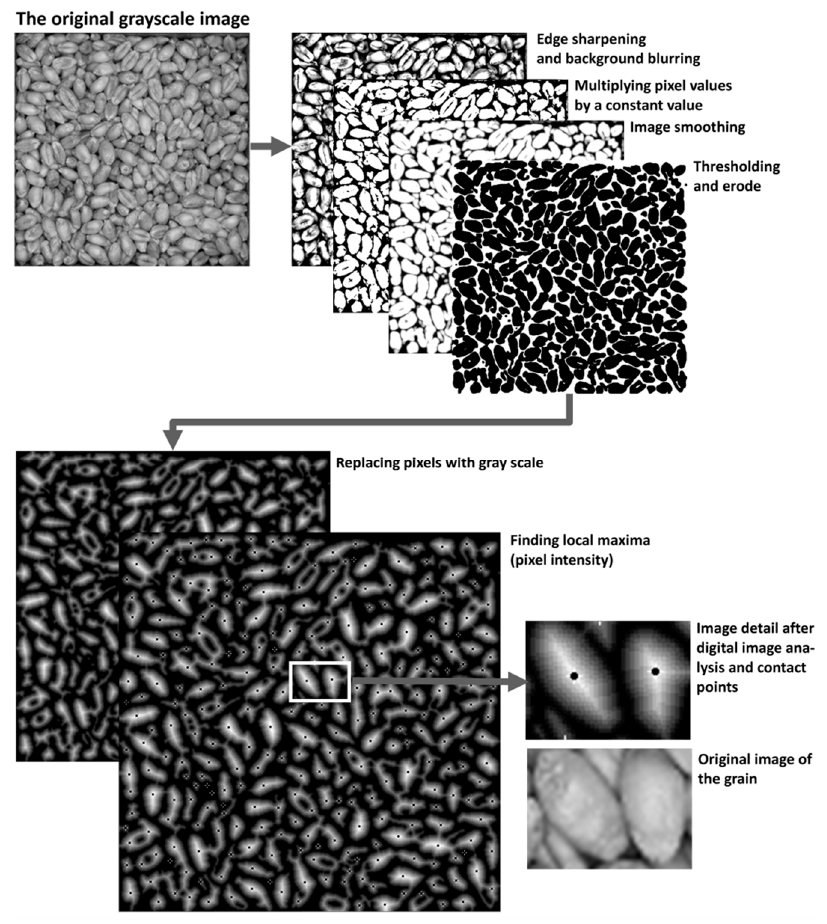
Figure 5. Algorithm of used digital image analysis for a sample image.